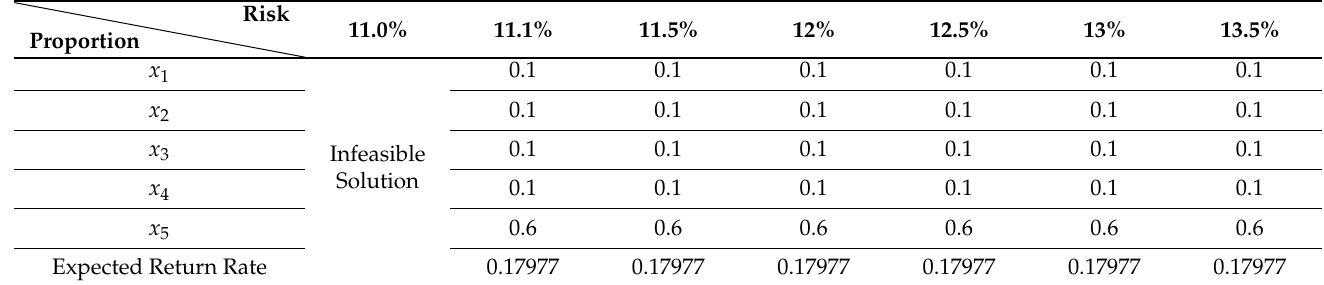
Table 3. The efficient portfolio with s = 2 in a guaranteed return rate (cid:101) p 3